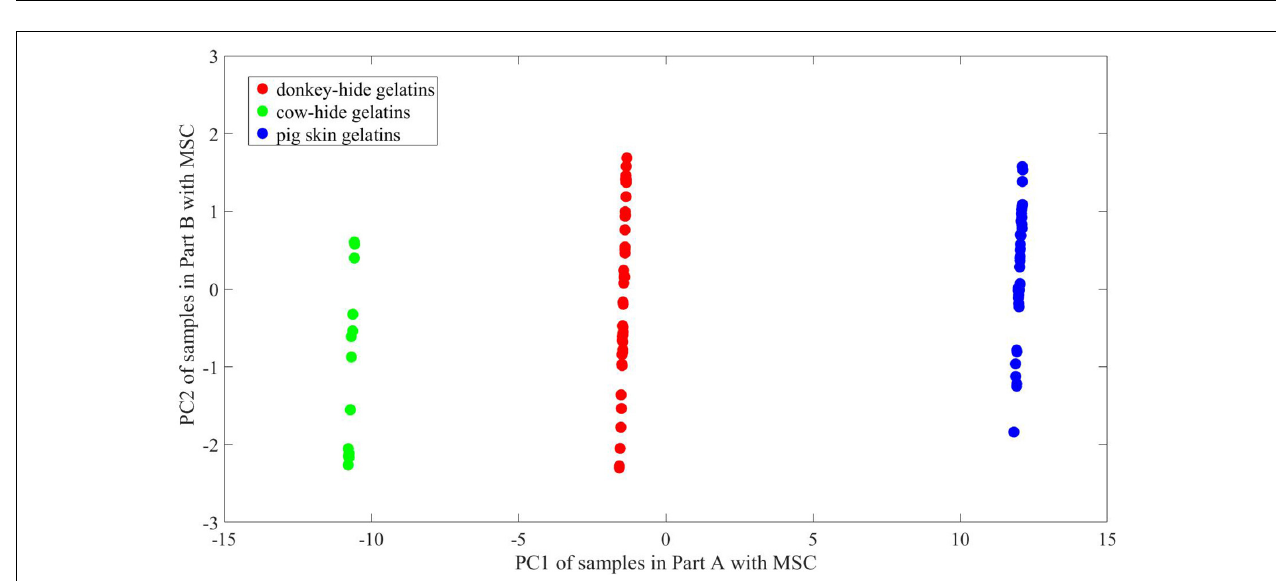
FIGURE 11 | 2-D PCA of samples in Part A with MSC.